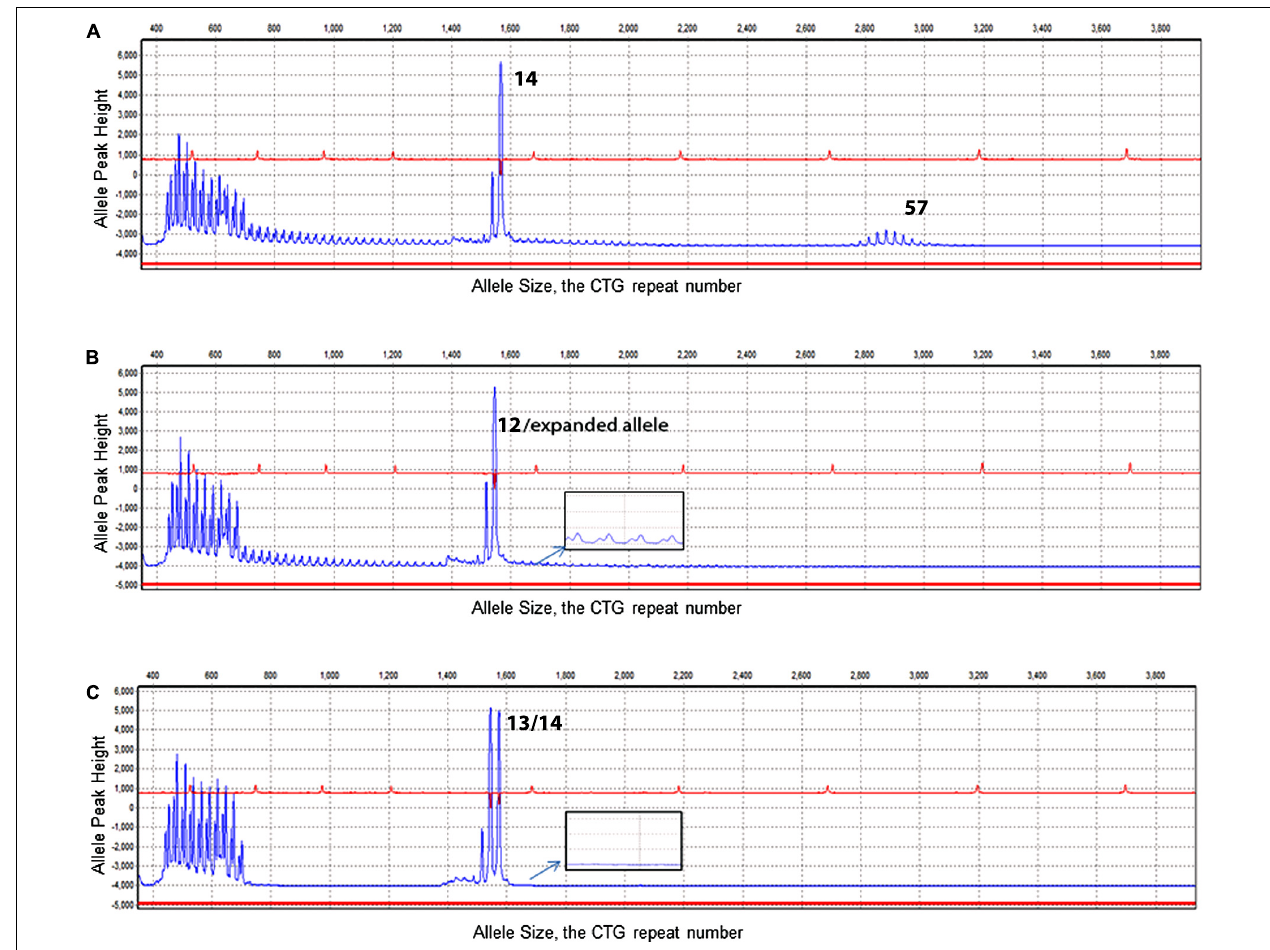
FIGURE 2 | Electropherogram results ofTP-PCR. X-axis illustrates the CTG repeat number.Y-axis illustrates the allele peak height. (A) Electropherogram of DM1 genotyping of a sample showing alleles of 14/57 CTG repeats. (B) Electropherogram result of a sample with a normal allele was determined